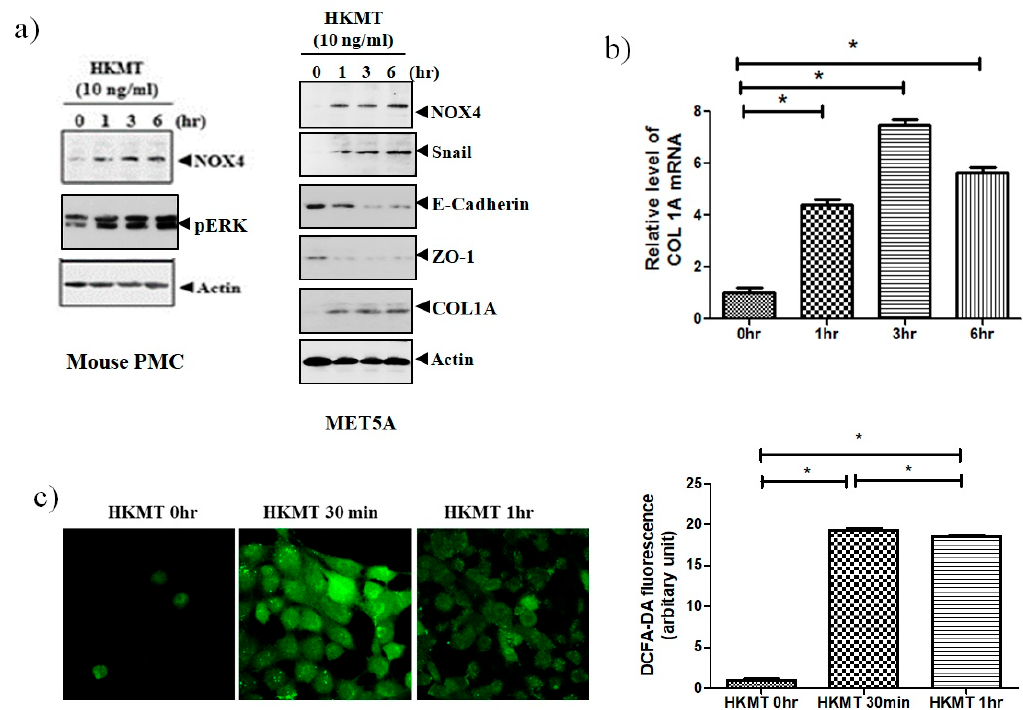
Figure 1. Heat-killed mycobacterium tuberculosis (HKMT) induces collagen I synthesis and NOX4–ROS expression in pleural mesothelial cells (PMC) ( a ) Western blotting analyses of NOX4, phosphorylated ERK, collagen, and EMT markers, ( b ) COL1A mRNA concentration by RT-PCR, ( c